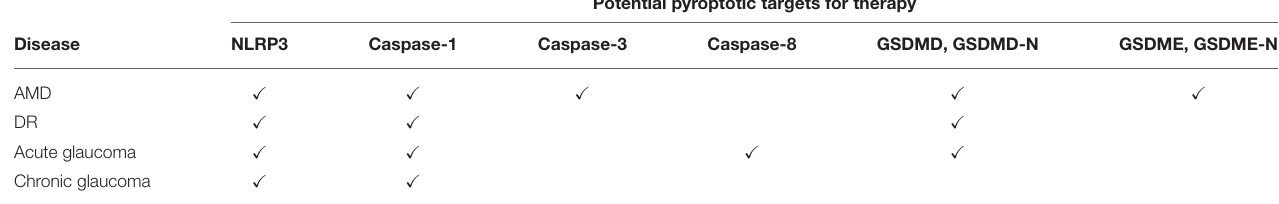
Potential pyroptotic targets for